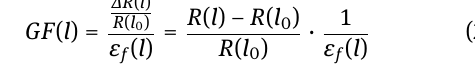
Figure 9: Gauge factor with respect to the relative strain, ε f , while accounting for the temporal